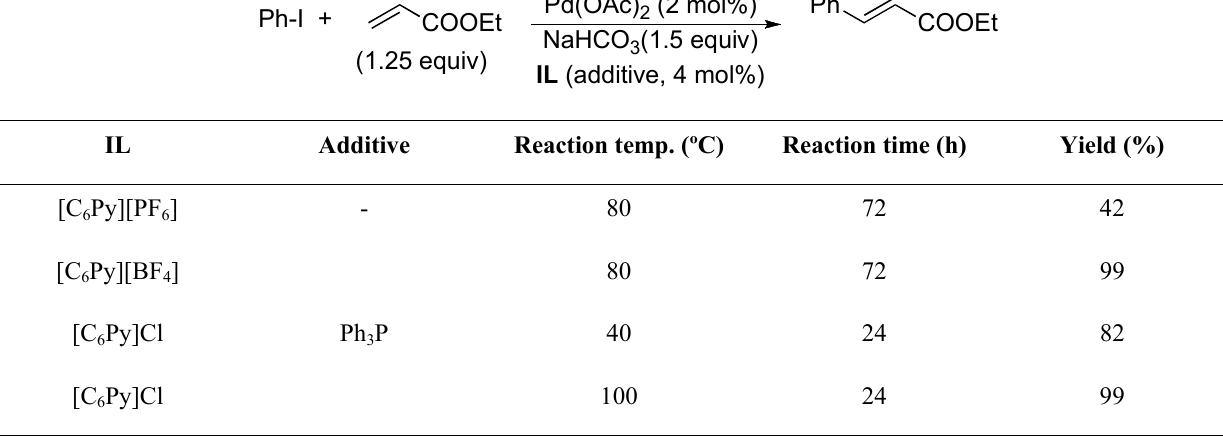
Table 1. Influence of the counteranion on the efficiency of the Heck